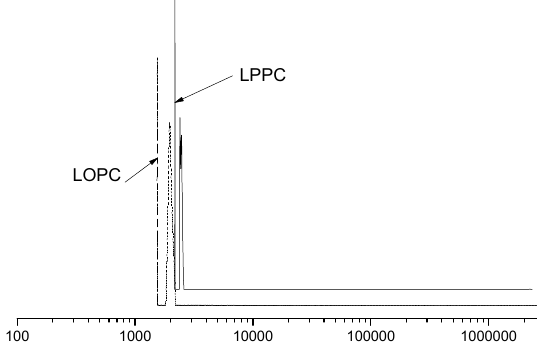
Figure 2. Molecular weight distribution of LPPC and LOPC.